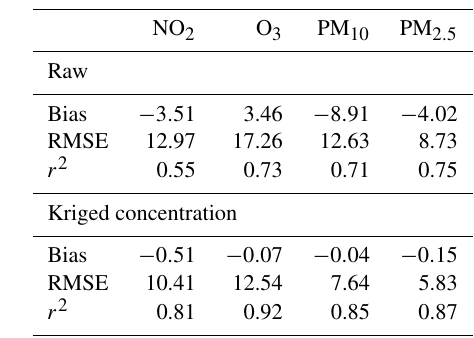
Table 3. Validation scores for the raw data and the kriged con- centrations (cross-validation). Annual scores (bias, RMSE and the Pearson correlation coefficient r 2 ) are calculated over France for all years and all stations and are